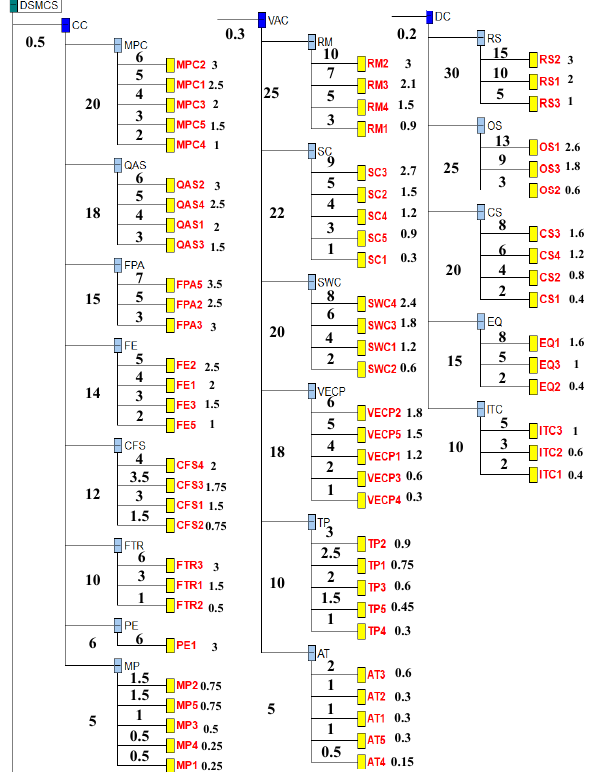
Figure 8. Weight model in